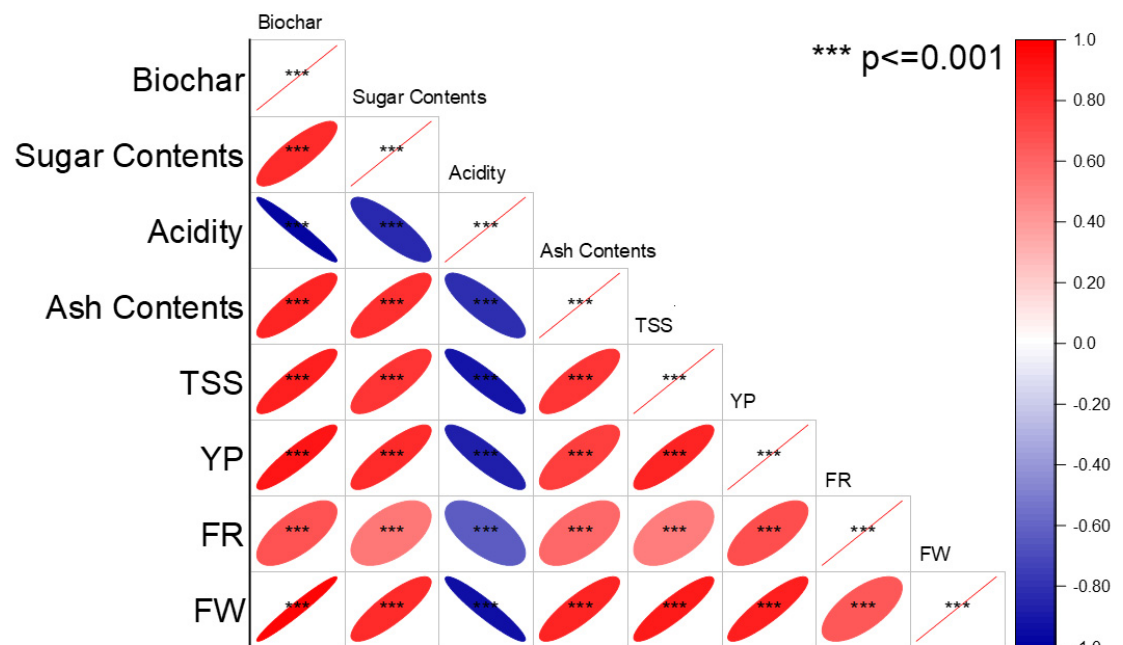
Figure 9. Pearson correlation for mango fruit attributes affected by different biochar application rates. Red color indicates positive correlation; blue color indicates negative correlation. Intensity of color shows the strength of correlation between attributes. TSS = total soluble solids; YP = yield per plant; FR = fruit retention; FW = fruit weight.